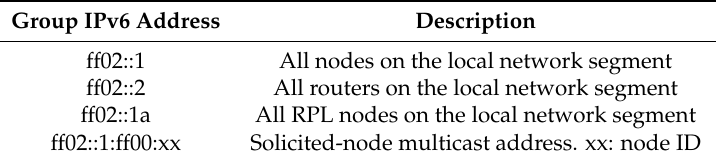
Table 3. When multicast is enabled on Contiki nodes, they automatically join four link-local groups. RPL, IPv6 Routing Protocol for Low-Power and Lossy